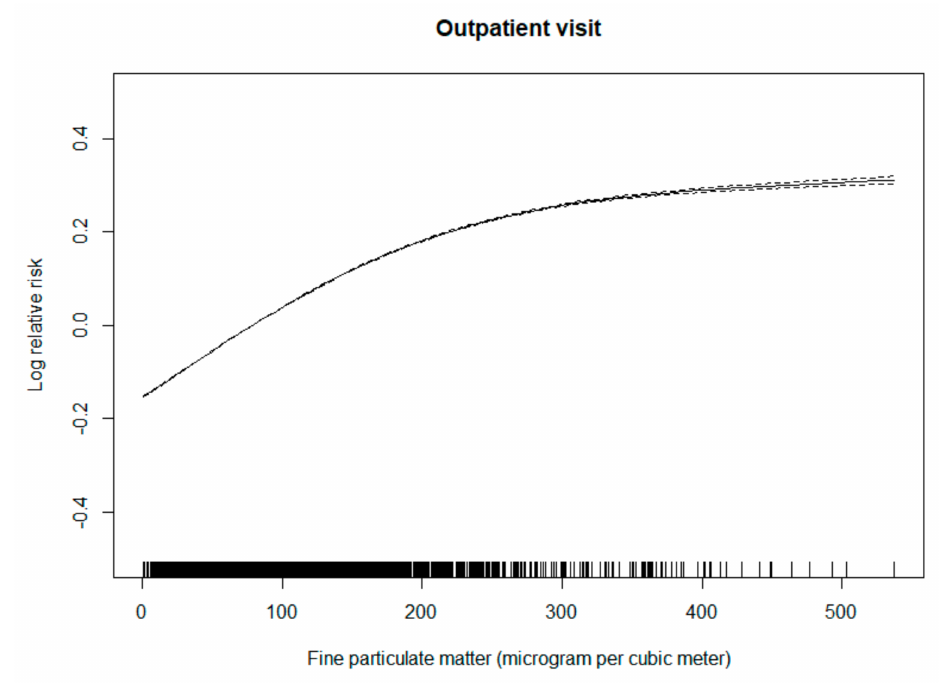
Figure 1. Exposure-response relationship of PM 2.5 concentrations with the number of daily outpatient visits for knee osteoarthritis. The concentration-response curve (solid line) is shown for the three degrees of freedom of the daily mean concentrations of PM 2.5 and the log-transformed value of the relative risk (after adjustment for temperature, relative humidity, public holiday, and day of the week) of outpatient visits for knee osteoarthritis between 1 January 2010, and 31 December 2017, in Beijing, China. The dotted lines indicate the 95% confidence intervals.